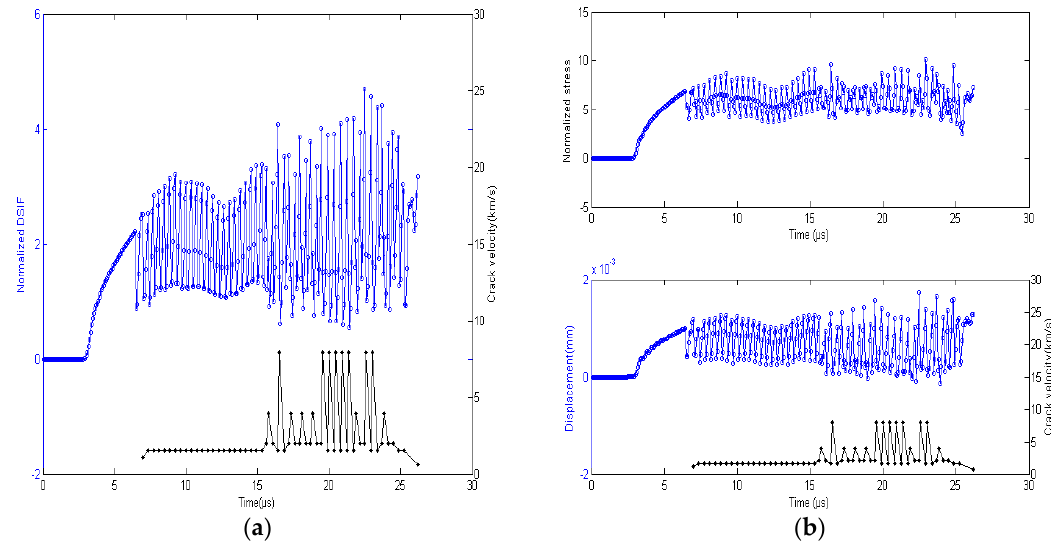
Figure 12. Dynamic stress intensity factor ( ) and crack propagation speed ( ) for Dynamic stress intensity factor ( Figure 11. Dynamic stress intensity factor ( ) and crack propagation speed ( ) for ) and crack propagation speed ( Figure 11. Dynamic stress intensity factor ( ) and crack propagation speed ( ) for =σ ( a ); and the stress and displacement near the crack tip for 550 M P a =σ ( a ); and the stress and displacement near the crack tip for 450 M P a c =σ ( a ); and the stress and displacement near the crack tip for σ c = 550MPa ( a ); and the stress and displacement near the crack tip for σ c = 550MPa ( b ). 450 M P a c c Crystals 2016 , 6 , x FOR PEER REVIEW